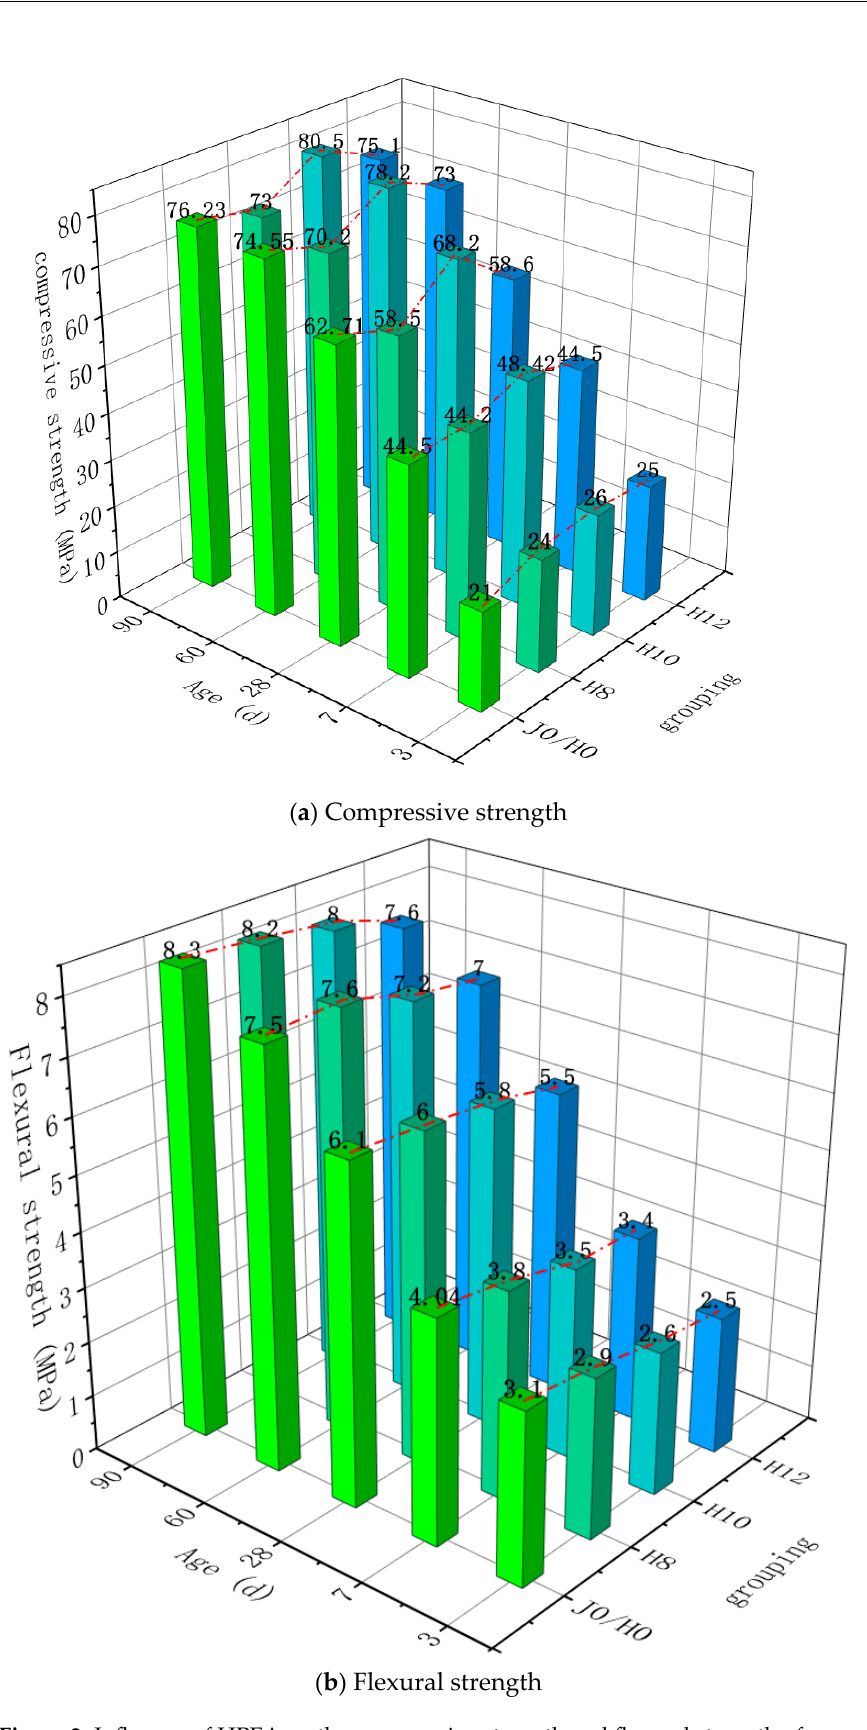
Figure 2. Influence of HPEA on the compressive strength and flexural strength of concrete.